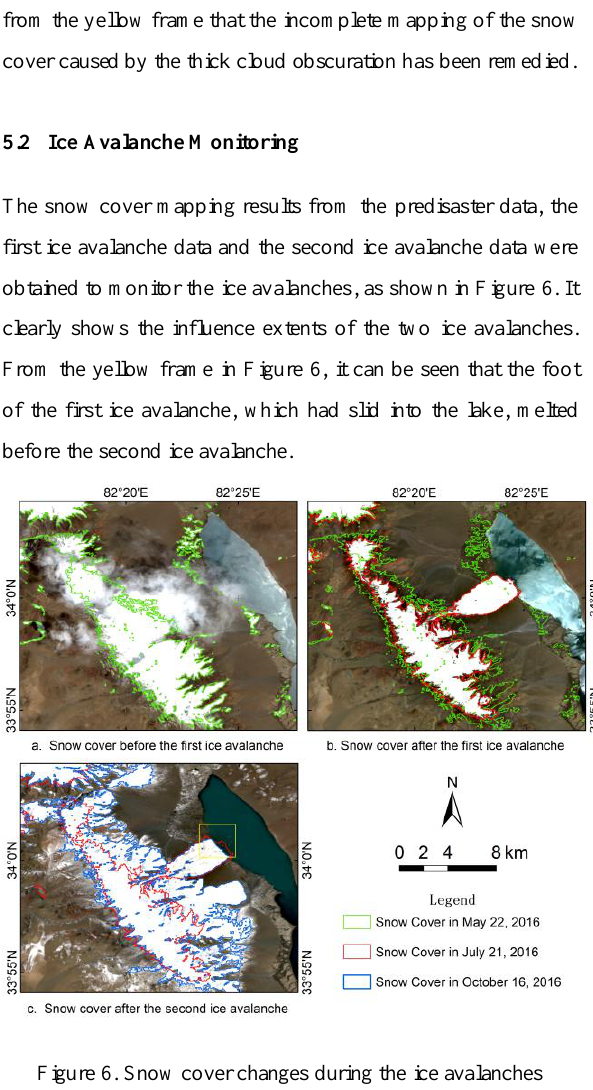
Figure 5. Snow cover mapping results from the Sentinels